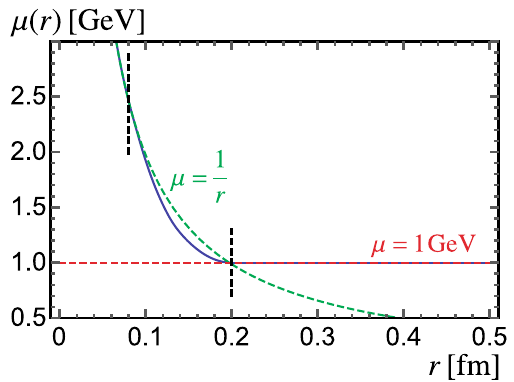
Fig. 6 Dependence of the static potential renormalization scale in Eq. (26) with r . In solid blue the profile function of Eq. (31) is shown, while dashed green and dashed red show the behavior for small (1 / r ) and large (constant) r , respectively. The positions in which the piece- wisefunctionchangesitsfunctionalformaresignaledbyverticaldashed black